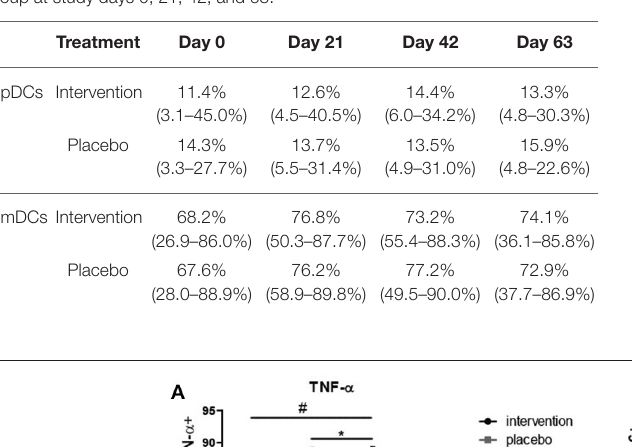
TABLE 3 | The percentage of pDCs and mDC (%pDC or %mDC of all DCs) in unstimulated PBMCs (median + range) for the nutritional intervention and placebo group at study days 0, 21, 42, and 63.